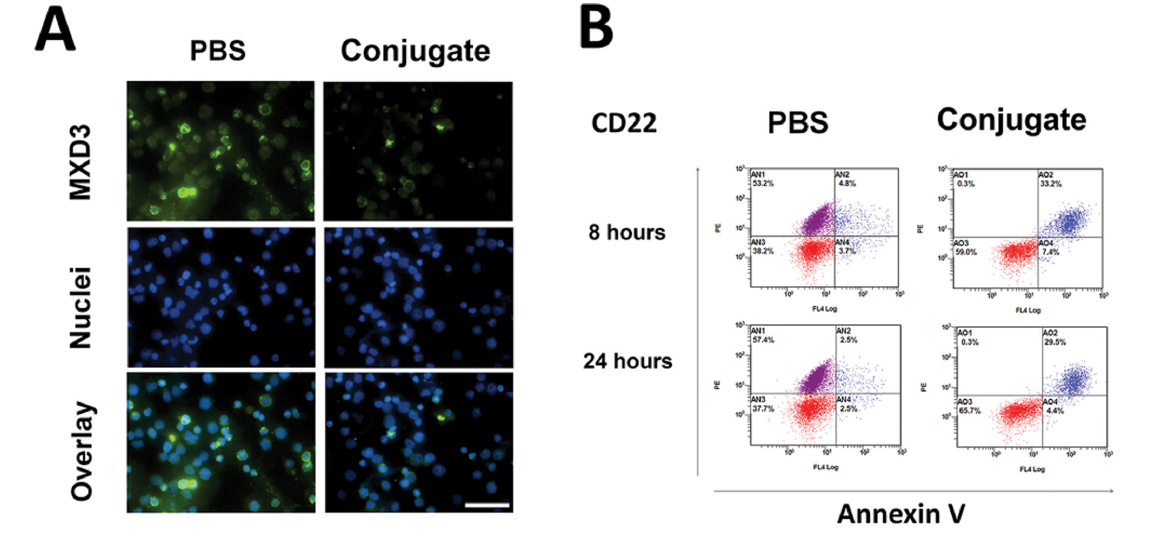
Figure 4. α CD22 Ab-MXD3 ASO conjugate shows in vivo anti-leukemic effects against engrafted leukemia cells in mice. (A) The α CD22 Ab-MXD3 ASO conjugate treatment showed MXD3 knockdown in the engrafted Reh cells at 8 h after treatment. MXD3 protein ex- pression was measured in the cells harvested from BM. Images were acquired at 40× magnification/1.4 numerical aperture at room temperature using a Nikon Ti-U inverted microscope and NIS-Elements BR software. Scale bar indicates 50 μ m. (B) The α CD22 Ab-MXD3 ASO conjugate treatment induced cell apoptosis in the engrafted Reh cells at 8 and 24 h after treatment. Cells were stained for human CD22 and annexin V. Red dots (lower quadrants): murine cells (CD22 negative), purple dots (upper left quadrant): live Reh cells (CD22 positive annexin V negative), and blue dots (upper right quadrant): apoptotic Reh cells (CD22 and annexin V positive) in